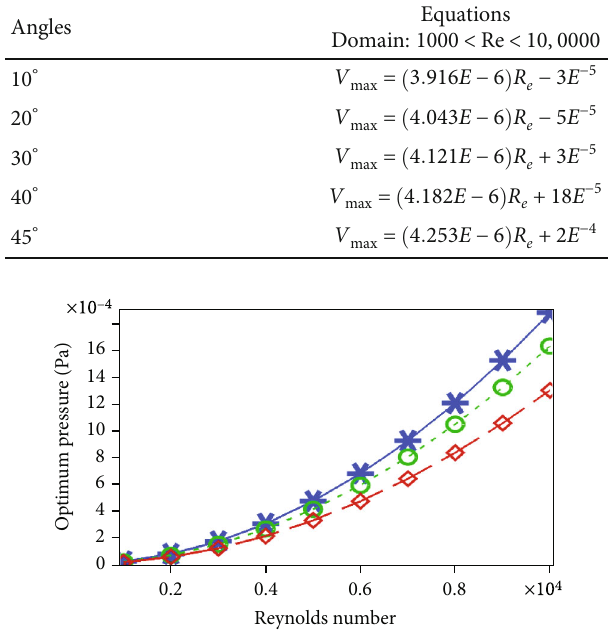
Table 2: Linear regression equations. Angles